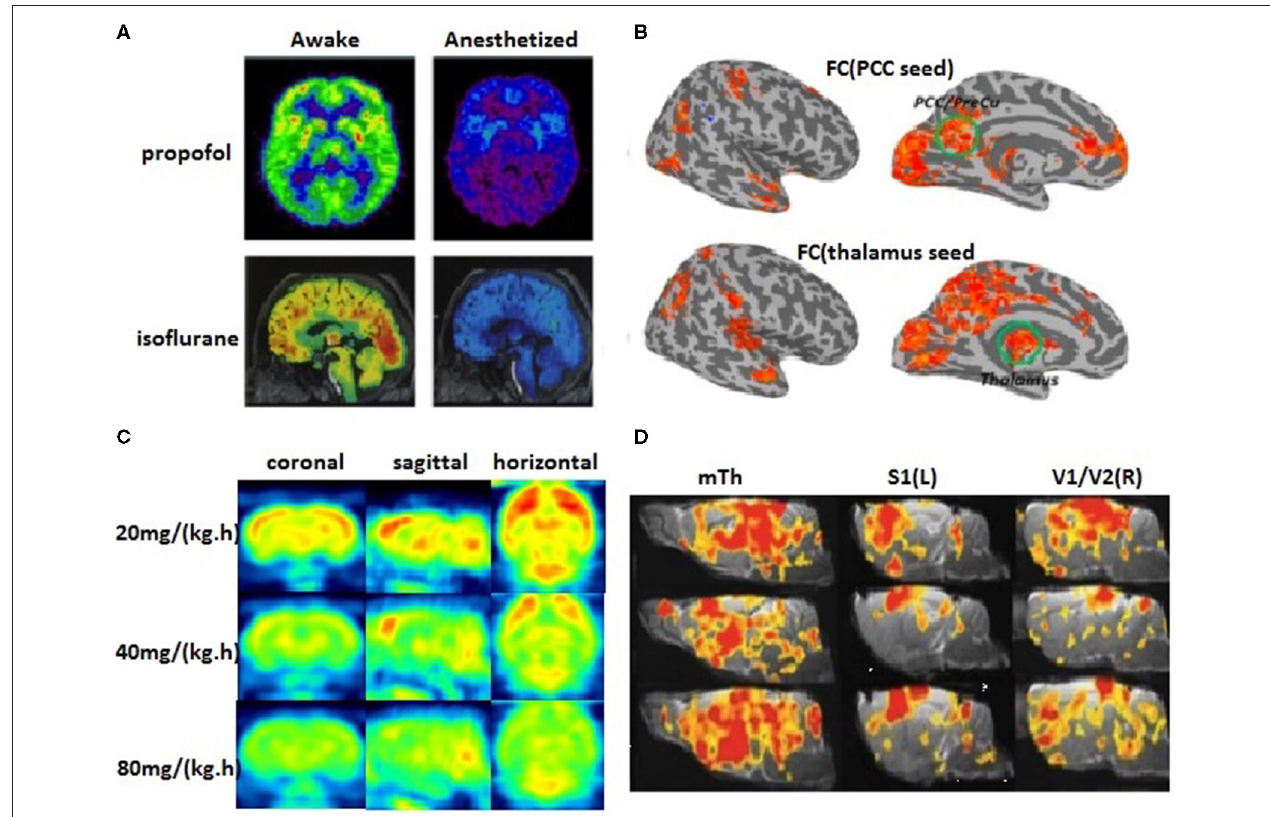
FIGURE 3 | The cerebral metabolic rate of glucose (CMRglc) and FC. (A) The PET scans are compared between awakefulness and uncosciousness induced by general anesthetics ( Nielsen et al., 2013). Red areas demonstrate the most significant findings and blue/purple the least, yet significant findings. (B) Group comparison of the FC with two seed regions in the posterior cingulate cortex (PCC) and the thalamus showed widespread reduced corticocortical and thalamocortical connectivity in the anesthetized state (Huang et al., 2014). (C) The metabolic rate of glucose in rat brains decreases correspondingly with the gradually deepened level of propofol anesthesia after intravenous infusion of 20, 40, and 80 mg/kg/h propofol (our unpublished data). (D) Dose-dependent change of brain FC in rat brains (Liu et al.,